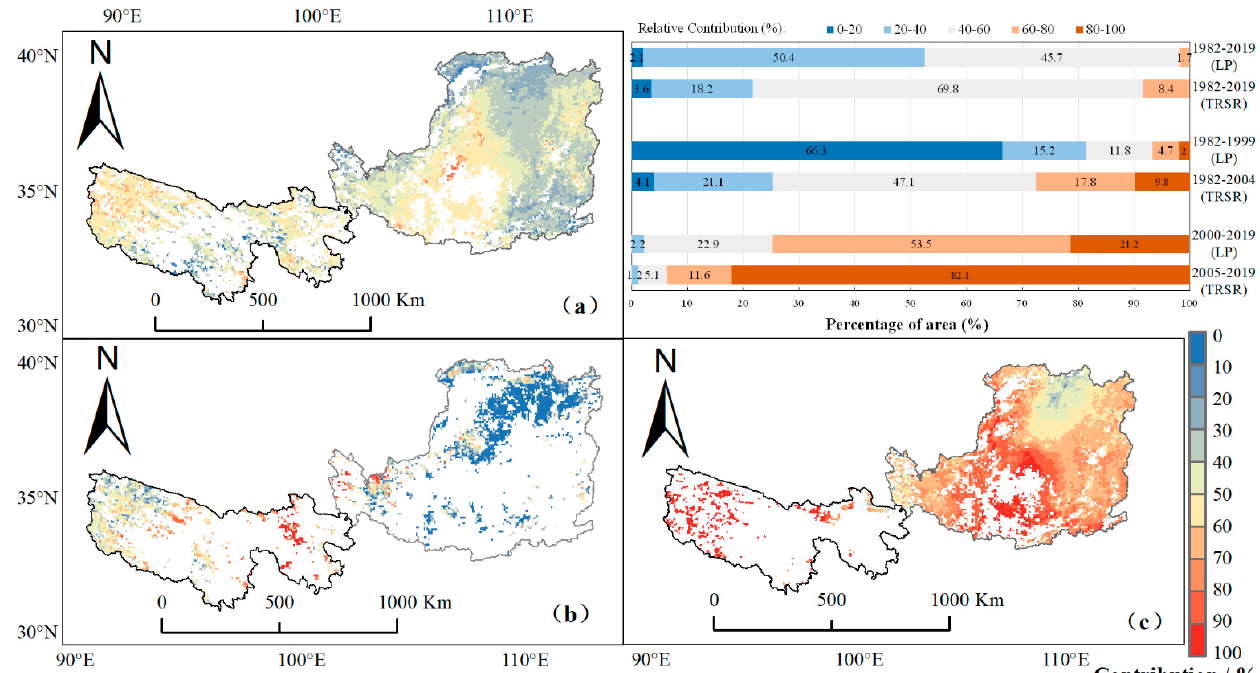
Figure 7. Spatial patterns of the linear regression coefficients between the LAI and TMP ( a ), PRE ( b ), RAD ( c ), VPD ( d ) during 1982–2019.